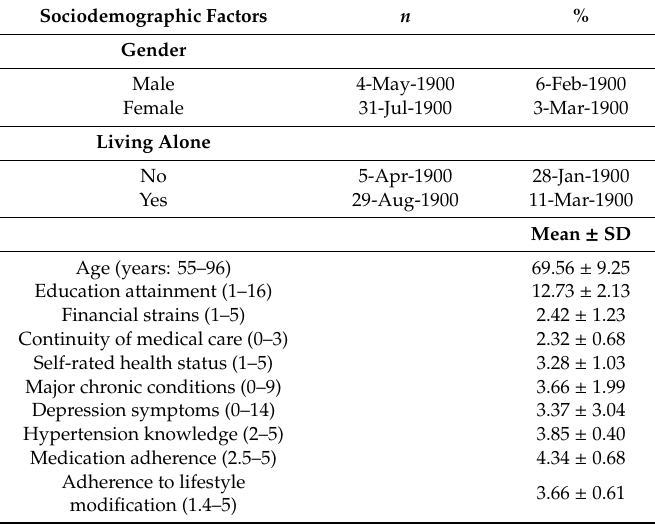
Table 1. Descriptive